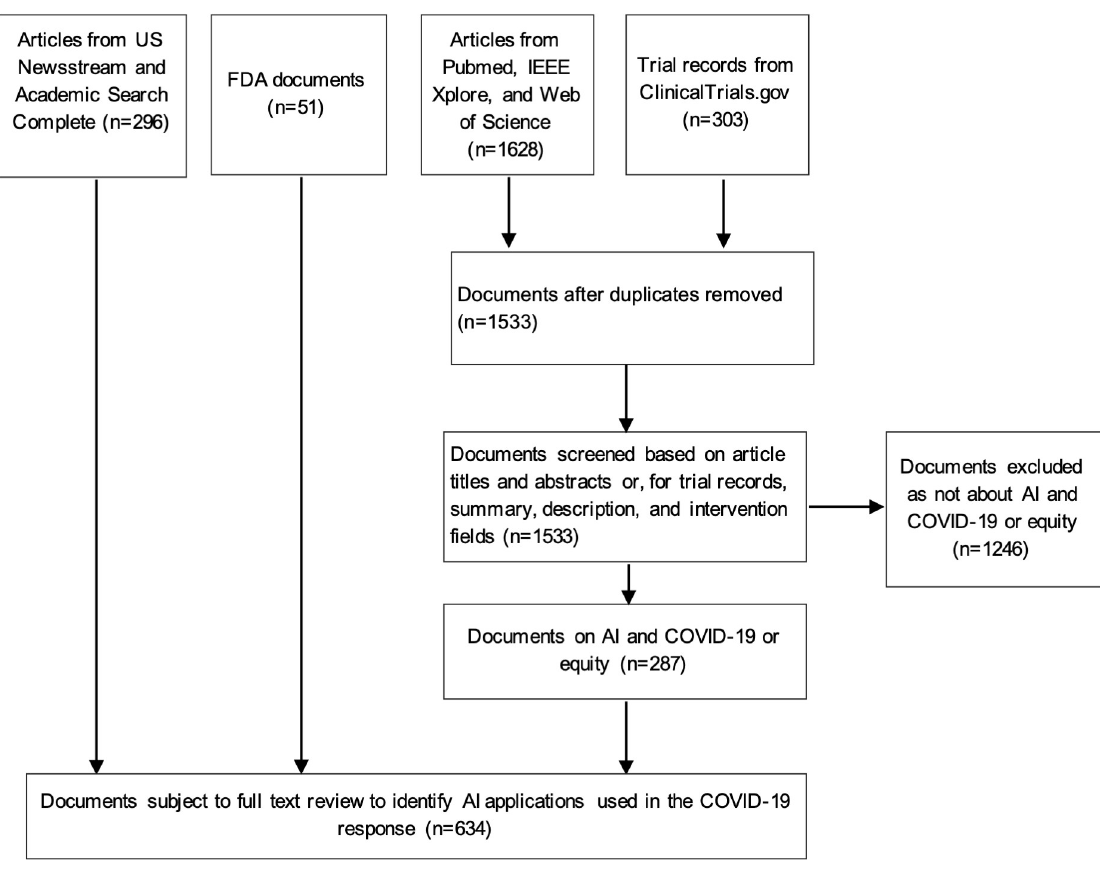
Fig 1. PRISMA Flow Diagram.